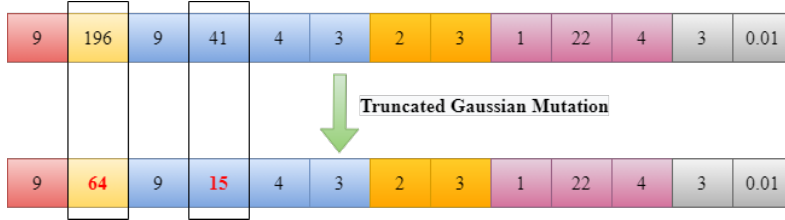
Figure 5. Truncated Gaussian mutation applied to CNN.